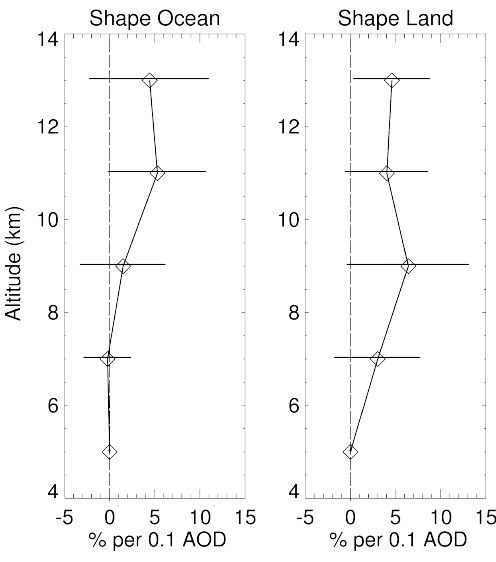
Figure 10. Vertical profiles of the means of the IWCshape regional and seasonal derivatives. MODIS “all AOD” data are used. Mean 95% confidence (2 σ) limits are indicated by the horizontal lines.